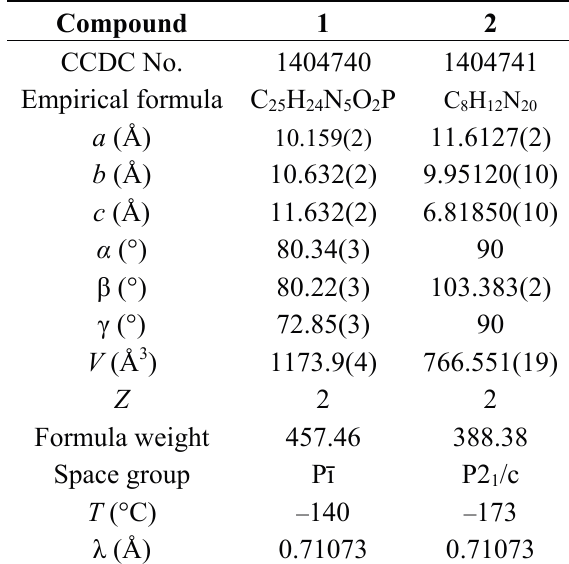
Table 1. Crystallographic data and structure refinement details for compounds 1 and 2 .